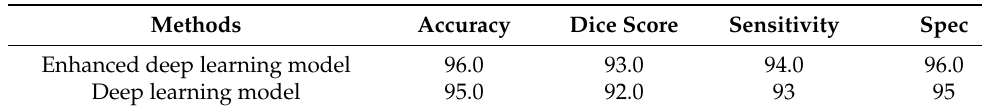
Table 6. Performance analysis (%) and comparison of the enhanced system with the method without enhancement on the PH2 datatest.